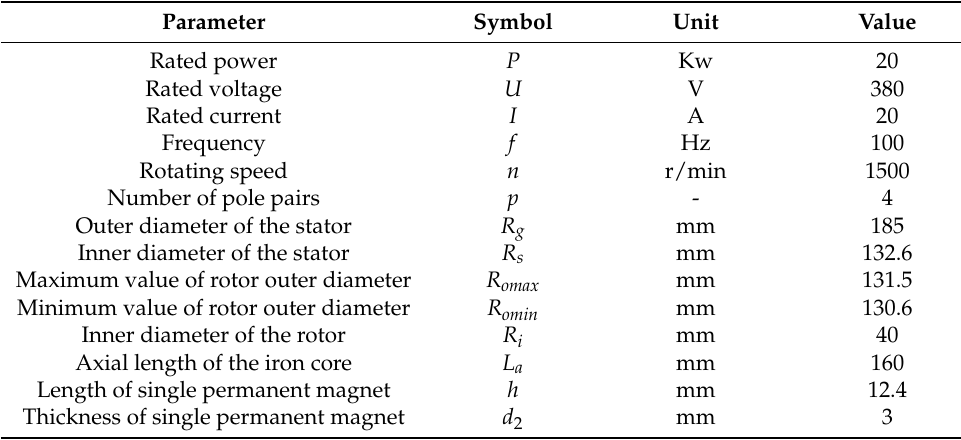
Figure 6. Schematic diagram of IPMSMB. Table 3. The basic parameters of